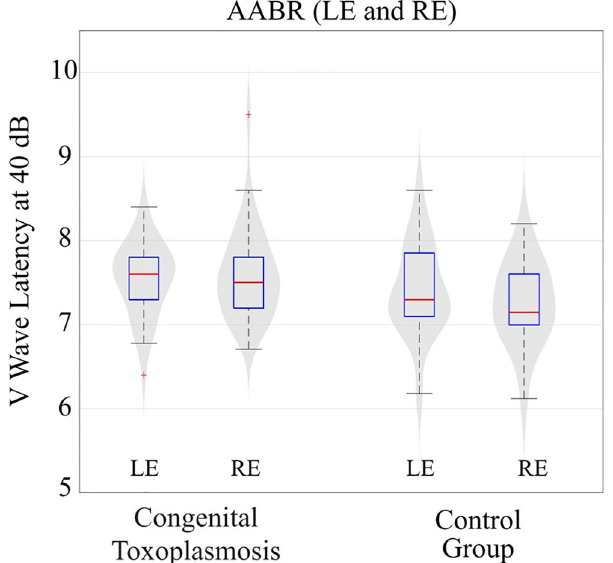
Figure 1. Analysis of wave V (ms) latency found in the AABR at 40 dB in the two groups studied. The points in red identified in our boxplot figure are outliers, that is, two extreme values were observed in our analysis of wave V of the AABR ( LE left ear; RE right